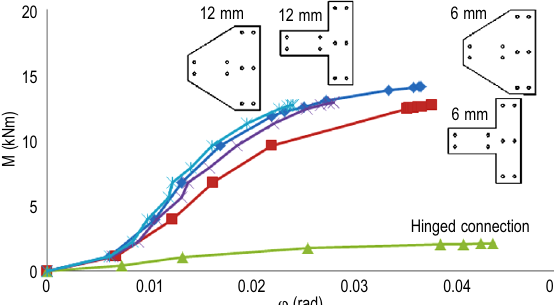
Fig. 10. Results of the connections of C150×40×1.5 sections